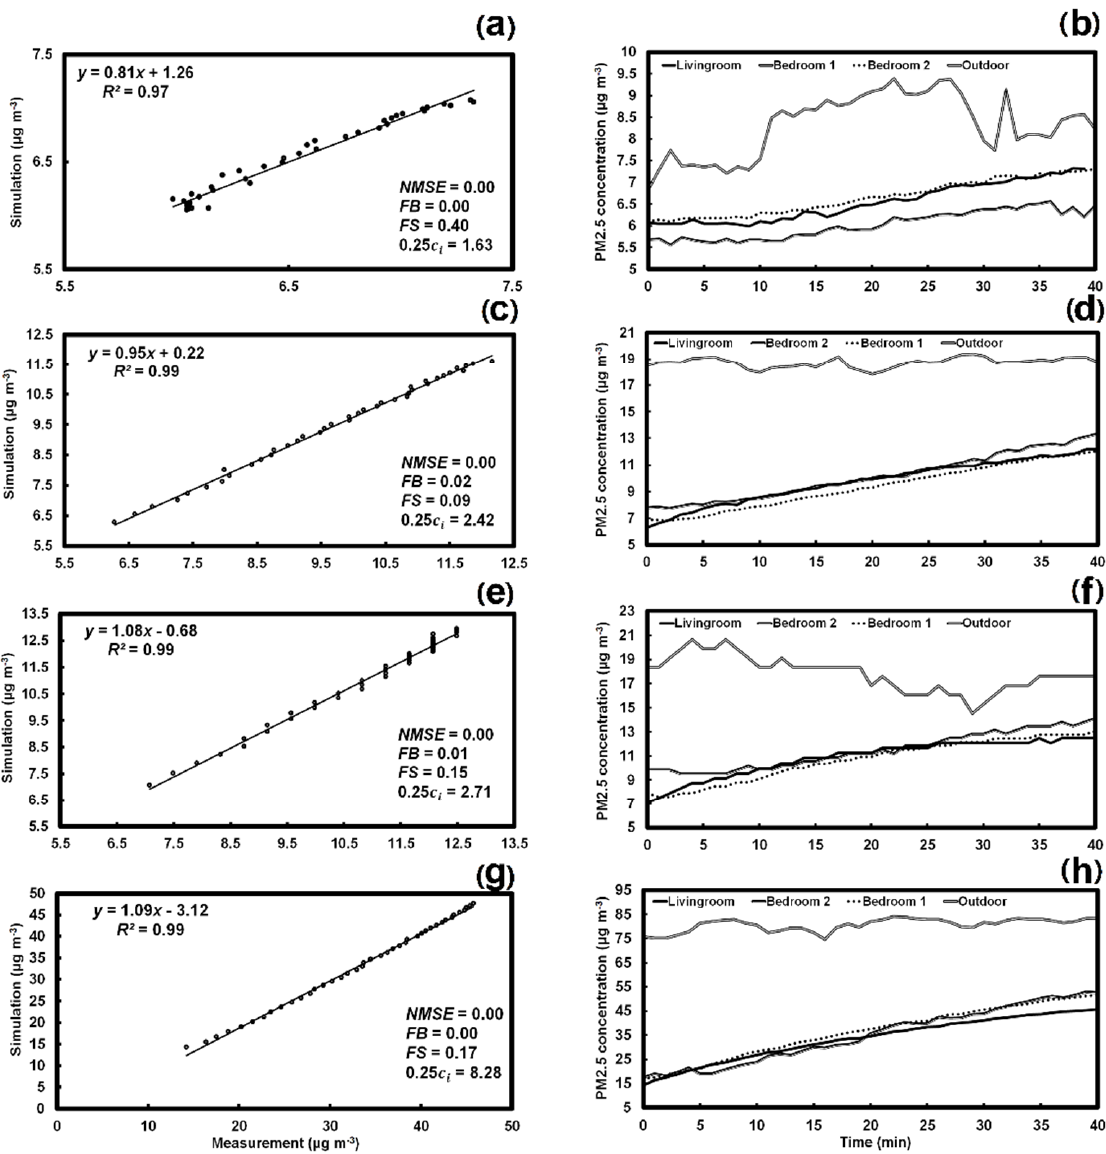
Figure 4. PM 2.5 concentration of CONTAM simulation and measurement in the living room ( a , c , e , g ) and the measured PM 2.5 concentration ( b , d , f , h ) in the living room and bedrooms 1 and 2, and outside under the 4 Pa depressurization set on four different days: 8 September ( a , b ), 9 September ( c , d ), 15 September ( e , f ), and 16 September ( g , h ). The y is the simulation, and x is the meas- urement.